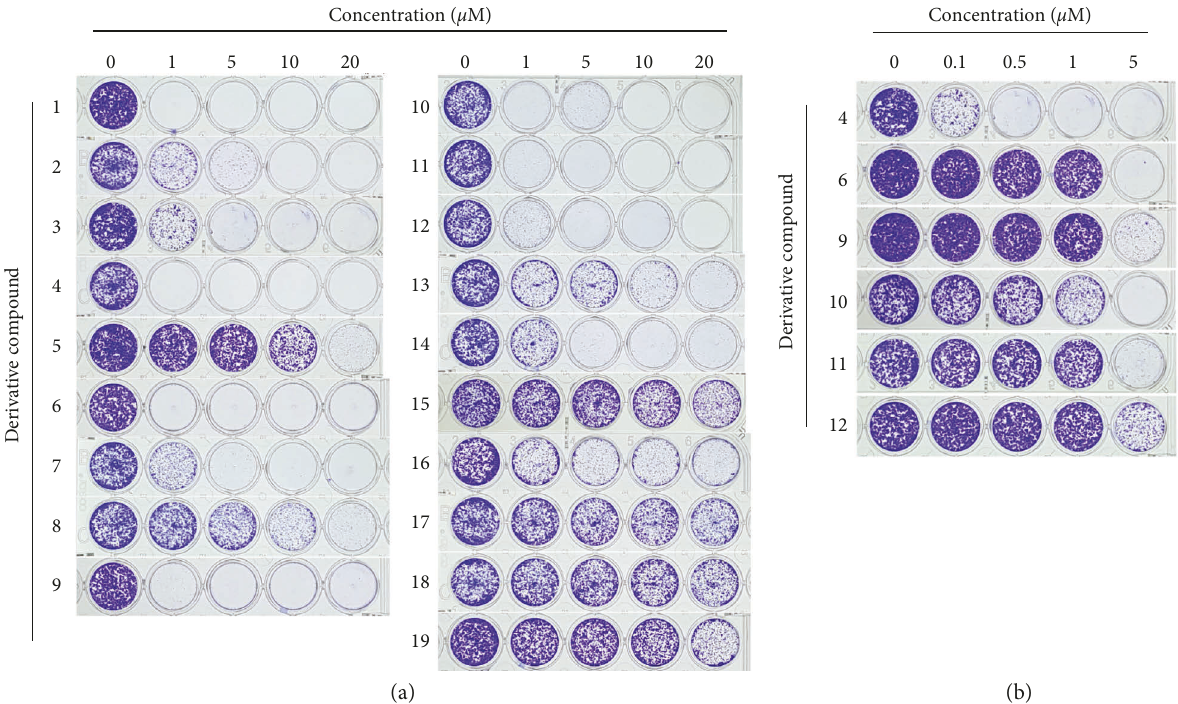
Figure 3: (a) Clonogenic long-term survival assay of 3,5-diphenyl-2-pyrazoline derivatives against HCT116 human colon cancer cells at different concentrations (0, 1, 5, 10, and 20 μ M) and (b) of derivatives 4 , 6 , 9 , 10 , 11 , and 12 at lower concentrations (0, 0.1, 0.5, 1, and 5 μ M). Table 1: The half-maximal cell growth inhibitory concentrations (GI 50 ) of 3,5-diphenyl-2-pyrazolines obtained by the clonogenic long-term survival assay of HCT116 human colon cancer